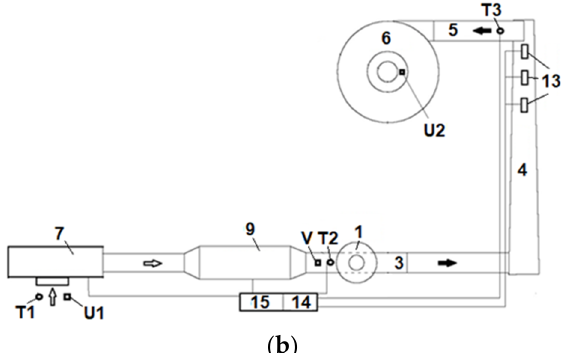
Figure 1. The hybrid dryer: ( a ) side view, ( b ) top view; 1. Wet seed hopper; 2. Lock; 3. Tangential pipeline inlet seeds; 4. Hybrid truncated cone dryer; 5. Tangential pipeline outlet seeds; 6. Cyclone; 7. Fan; 8,10. Link pieces; 9. Air heating battery; 11. Warm air pipe; 12. Support brackets; 13. Antennas; 14. Temperature monitoring; 15. Energy monitoring; T1. Air temperature sensor, T2. Input air temperature sensor; T3. Output air temperature sensor; U1. Input air humidity sensor; U2. Output air humidity sensor; V. Air velocity sensor.